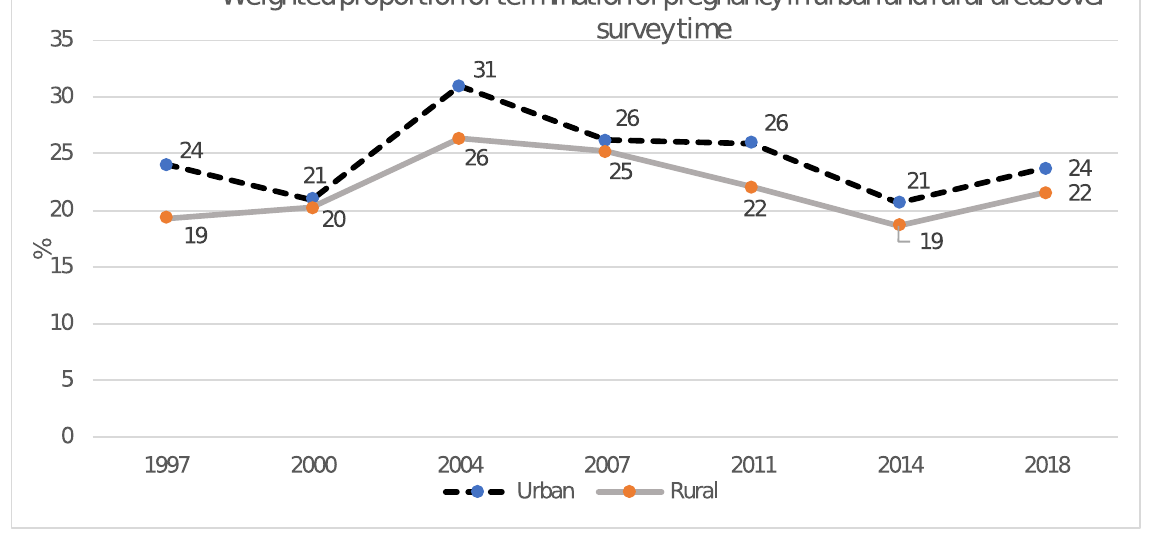
Fig 1. Weighted proportion of fatal pregnancy termination in urban and rural areas over survey